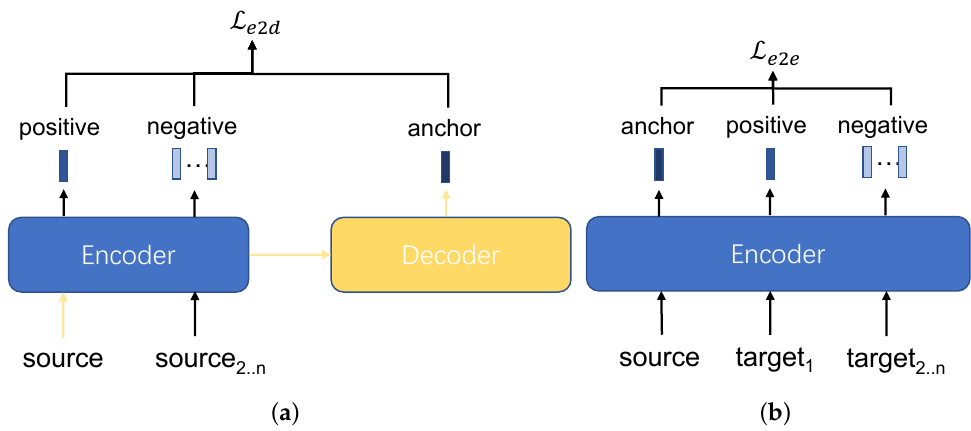
Figure 1. The semantic agreement in our model. ( a ) is the semantic agreement between the source and generated sentences. It uses the generated and source sentences as the positive pair and the generated and randomly sampled source sentences as the negative pair. ( b ) is the semantic agreement in the encoder. Different from ( a ), it only uses the representation output by the encoder. Furthermore, it utilizes the source and corresponding target sentences as the positive pair and the source and randomly sampled target sentence as the negative pair. Our model computes the contrastive loss L L e 2 e on the representation of the positive and negative e 2 d and